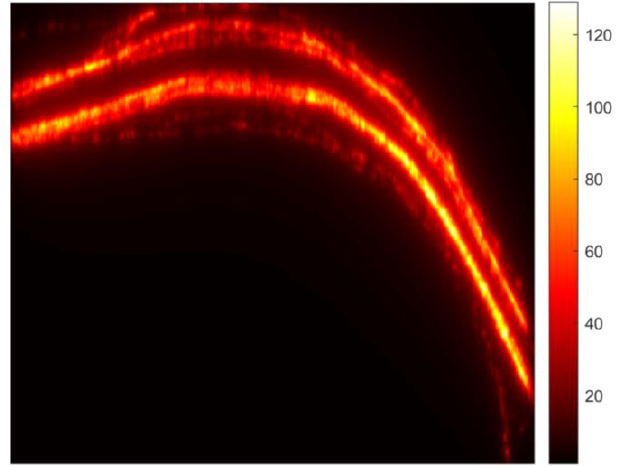
Figure 6. Density map of ship positions in the Nantong Port AIS dataset.